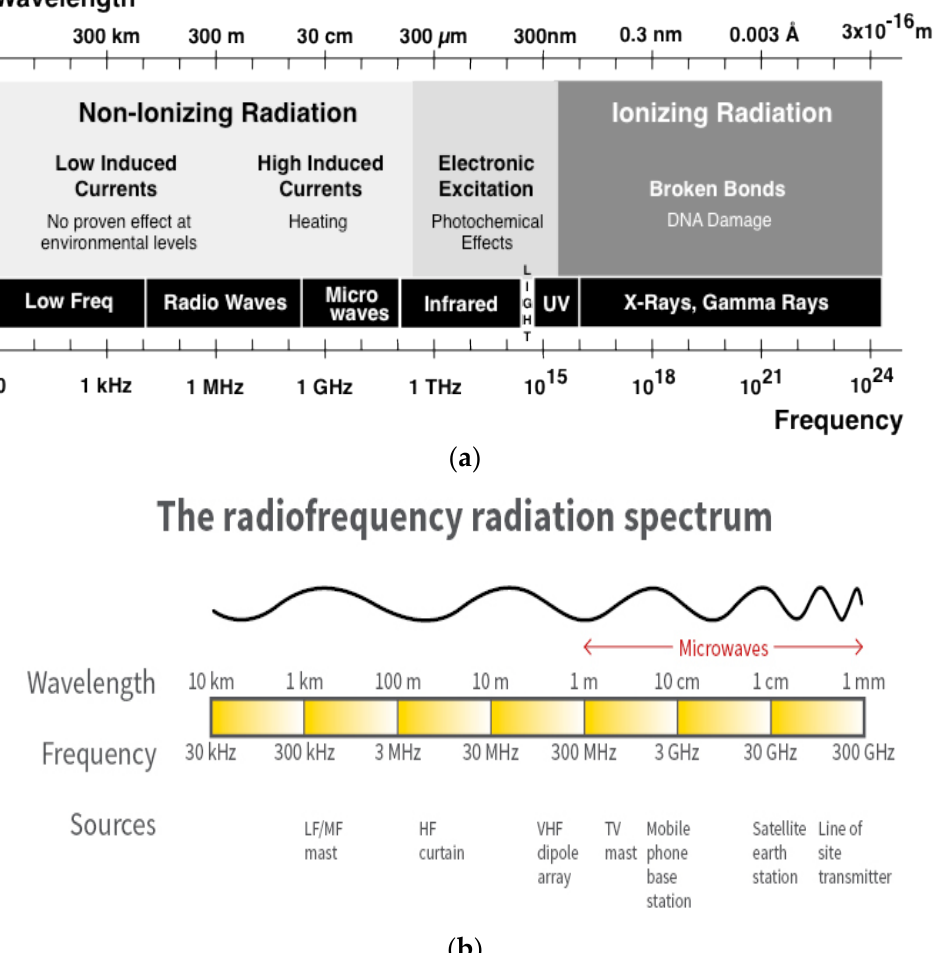
Figure 1. EMF frequency and wavelength ranges ( a ) ionizing and non-ionizing, ( b ) RF.